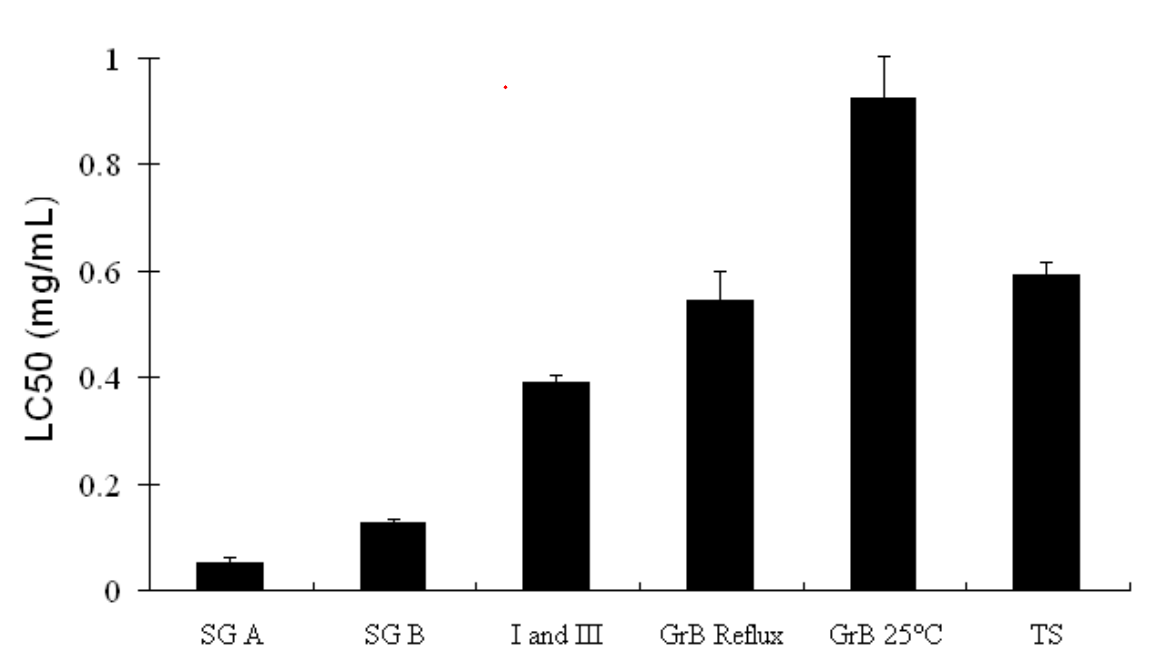
Figure 2. The effect of various soyasaponin extracts on hepatacarcinoma cells line (Hep- G2) viability after 72 hours of